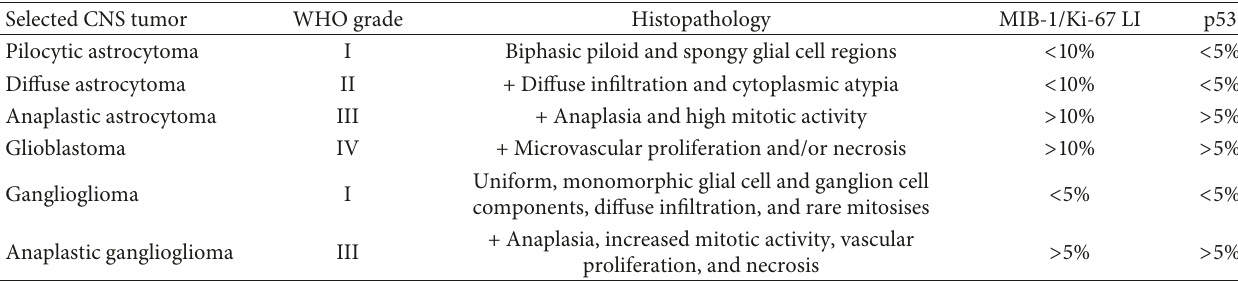
Table 1: Selected CNS gliomas. Comparison of basic histopathologic findings and immunostaining characteristics ∗ . Selected CNS tumor